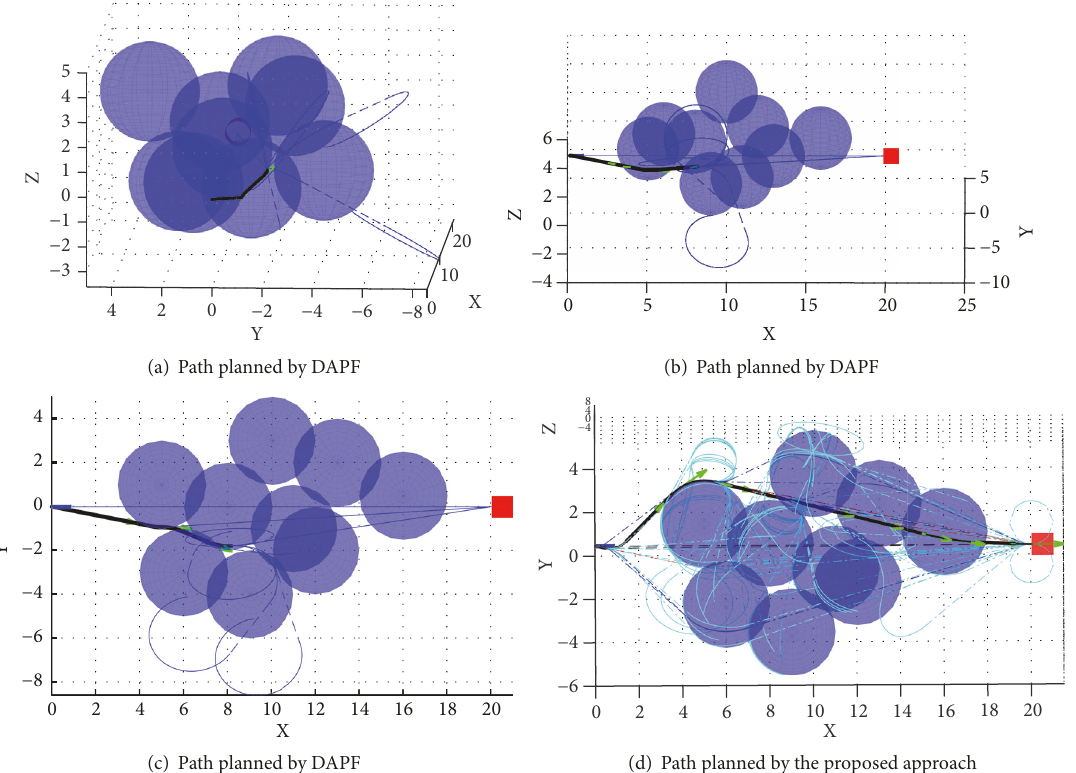
Figure 9: Simulation results of the DAPF and the smooth path planning approach in case 2, scenario